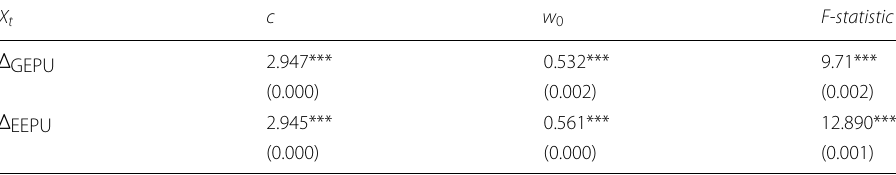
Table 2 Results of regression-based